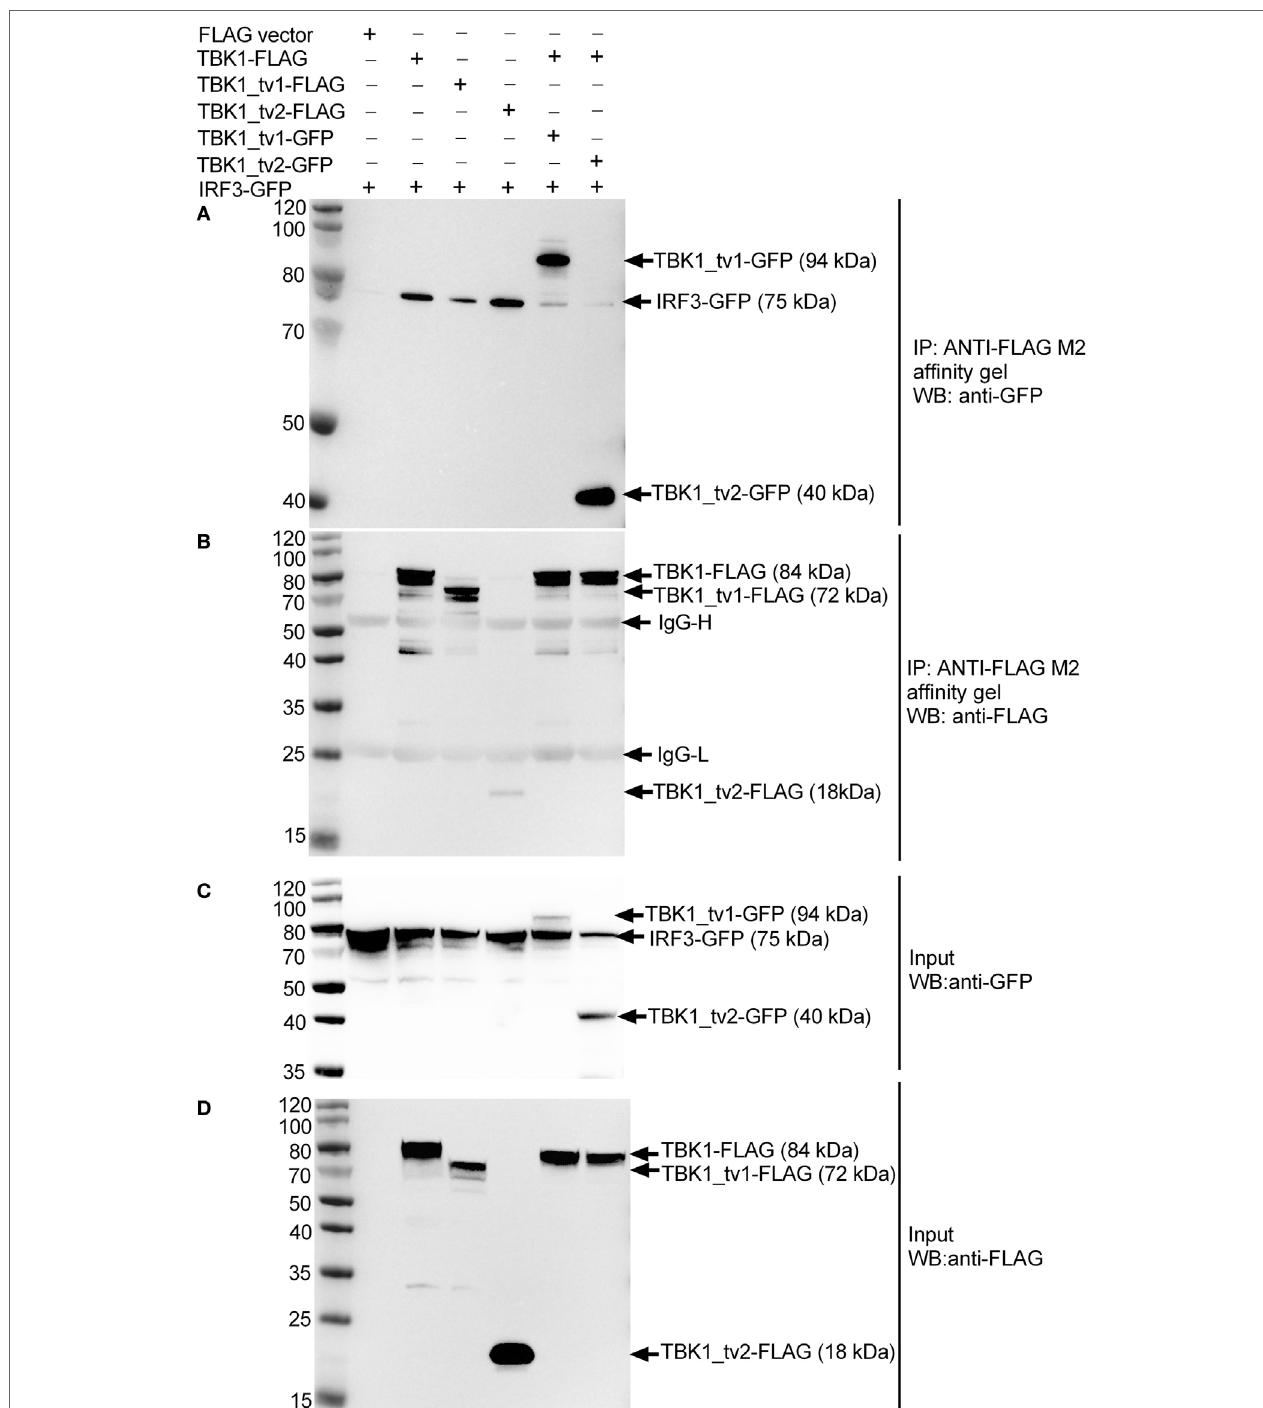
FigUre 7 | TANK-binding kinase 1 (TBK1) isoforms associate with TBK1 and IRF3 to disrupt TBK1-IRF3 interaction in uninfected HEK293T cells. HEK 293T cells seeded in 25 cm 2 cell culture flask were transfected with various indicated plasmids. 24 h post transfection, cell lysates were immunoprecipitated with anti-FLAG antibody (covalently conjugated to agarose beads) and immunoblotted with anti-GFP (a) or anti-FLAG (B) antibody. The input proteins were also analyzed by immunoblotting with anti-GFP (c) or anti-FLAG (D) antibody.